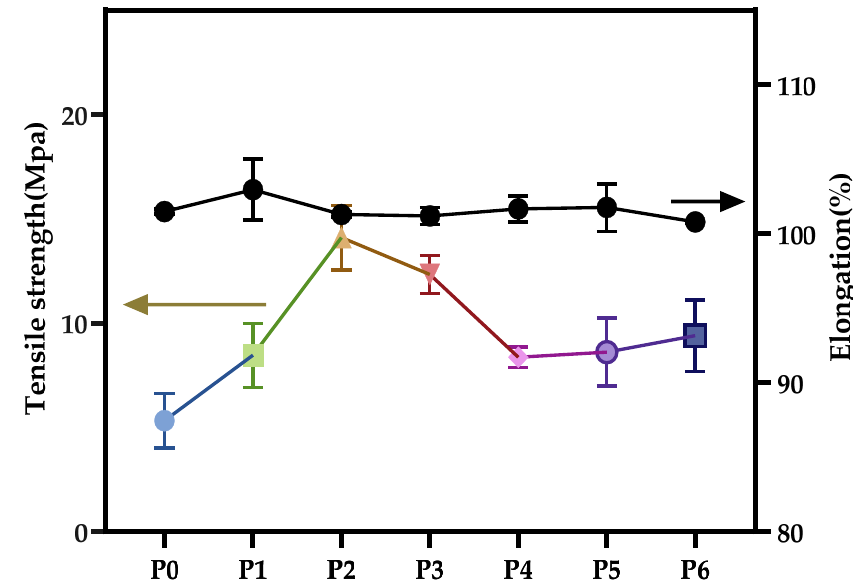
Figure 13. Tensile strength and elongation at break of various PA66 membranes.